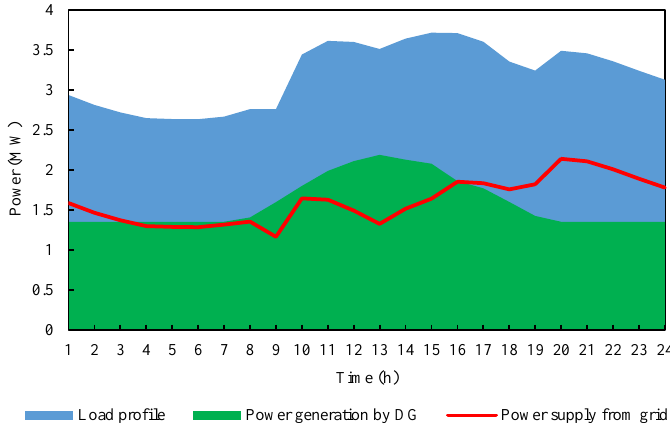
Figure 7. Daily load curve and power supply by grid and DGs.